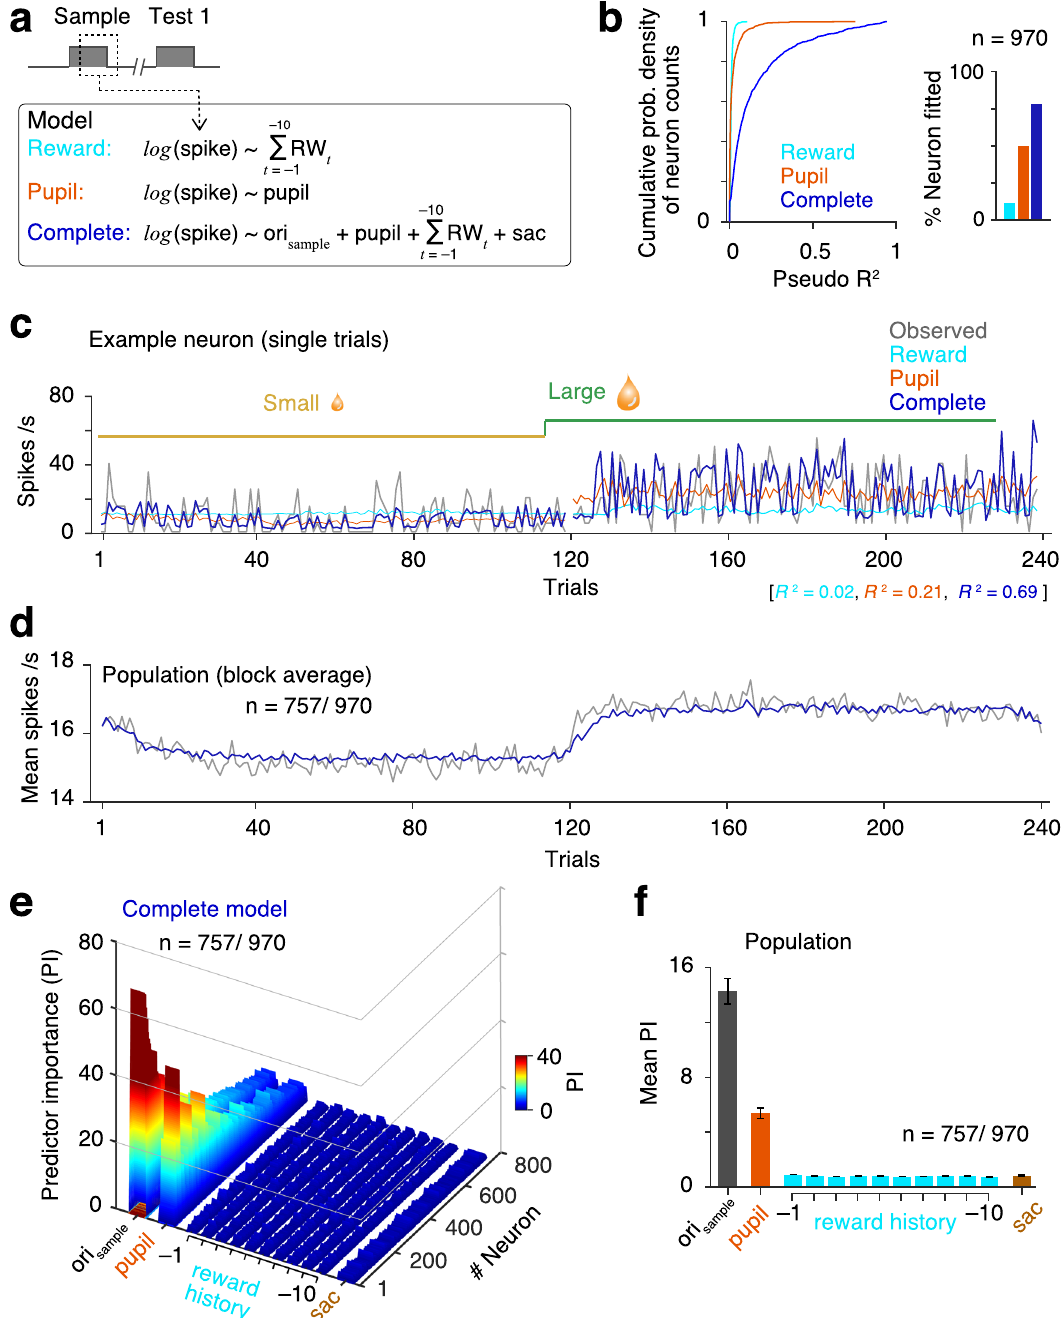
Fig. 6 Encoding of cognitive states by single-trial spike counts. a Top, generalized linear models (GLM) on single-trial spike counts during sample stimuli period (60 – 260 ms from sample onset). Spike counts were fi t with three different GLMs. Two were reduced models, based on either reward history (ten immediate past received rewards; reward model) or mean pupil area over 400 ms following stimulus onset (pupil model). A more detailed model contained multiple experimental and cognitive variables that included reward history (past ten trials), pupil area, saccade response, and Gabor stimulus orientation (complete model). b Left, cumulative probability densities of pseudo R 2 values (see “ Methods ” ) of single neurons measure goodness of fi t for different GLMs. Right, fraction of the neuron population that were fi t signi fi cantly better ( p < 0.05, F -test) compared to a null model (a constant) (reward model, 114/970 (12%); pupil model, 483/970 (50%); complete, 757/970 (78%)). c Observed and model-predicted spike counts on single trials from cross-validation test data set for an example neuron in two representative reward blocks. d Population-averaged observed and fi tted (complete model) spike counts. Gray, observed; blue, complete model. e Comparing predictor importance (PI) that measures contributions of different predictor variables estimated by absolute standardized predictor coef fi cient values. Colormap represents PIs of all neurons that were fi t with the complete model ( n = 757, p < 0.05; F -test). Neurons were sorted based on the pseudo R 2 values. f Population-averaged PIs well fi t neurons ( n = 757) presented as mean with 95% con fi dence intervals (bootstrap, n = 10 4